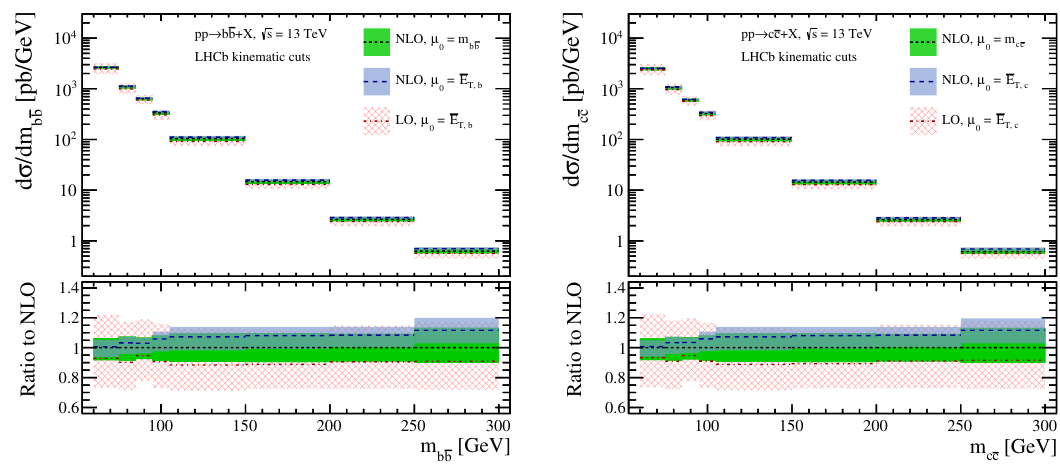
p Figure 2 . Di(cid:11)erential b (cid:22) b (left) and c (cid:22) c (right) cross sections for pp collisions at s = 13 TeV in the (cid:12)ducial region (2.2). The NLO distributions employ the two scale choices (cid:22) 0 = m and Q (cid:22) Q (cid:22) 0 = E T;Q , and LO distributions obtained with (cid:22) 0 = E T;Q are also shown. The lower part of each panel displays the distributions normalised to the central NLO prediction obtained with (cid:22) 0 = m . Q (cid:22) Q bins of width 4 GeV in the Z -pole region, suggesting that future measurements of inclusive heavy-quark pair production will also be possible with similarly (cid:12)ne binning. In (cid:12)gure 3 we provide predictions for both bottom (left) and charm (right) jet-pair production, focussing 2 [60 ; 120] GeV. Besides the total rates also spectra of on the invariant-mass region of m Q (cid:22) Q the various subprocesses are shown. At LO we display the purely QCD ( (cid:11) 2 ) and EW ( (cid:11) 2 ) s contributions, while at NLO we have chosen to depict various combinations of mixed QCD- EW corrections. When considering the EW corrections to the LO QCD processes ( (cid:11)(cid:11) 2 ) s only the values of the NLO coe(cid:14)cient is displayed, where we have separated the impact of the QED and weak corrections. The QED corrections in this case are negative, and thus the absolute values of the NLO coe(cid:14)cient are shown. In the case of the QCD corrections to the LO EW processes ( (cid:11) 2 (cid:11) s ) the sums of the LO and NLO coe(cid:14)cients are given, where we have also displayed the result when including only initial-state radiation (ISR) from QCD (labelled as ISR